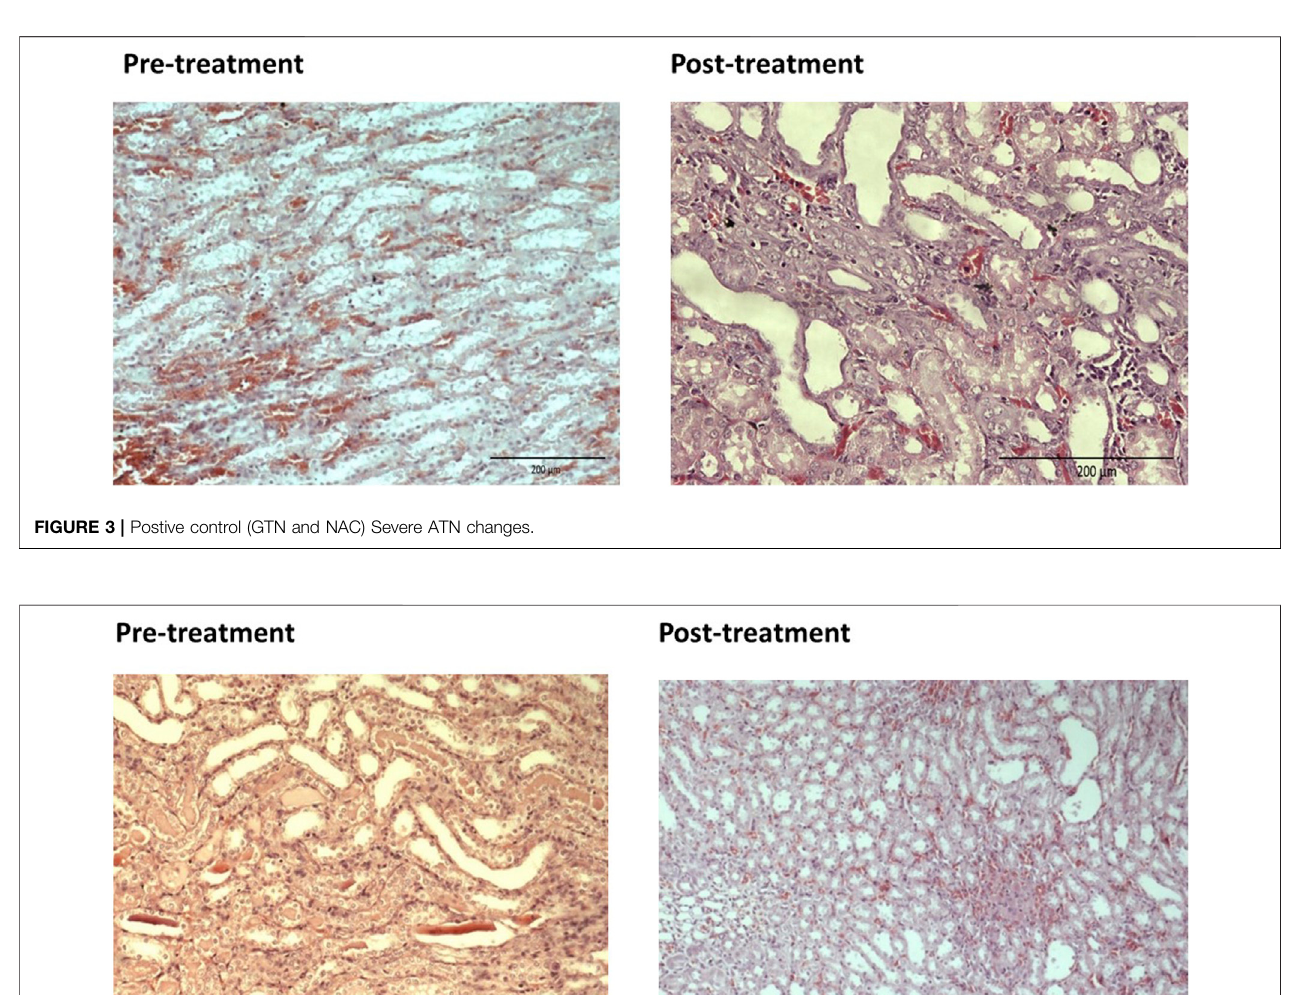
Frontiers in Pharmacology |